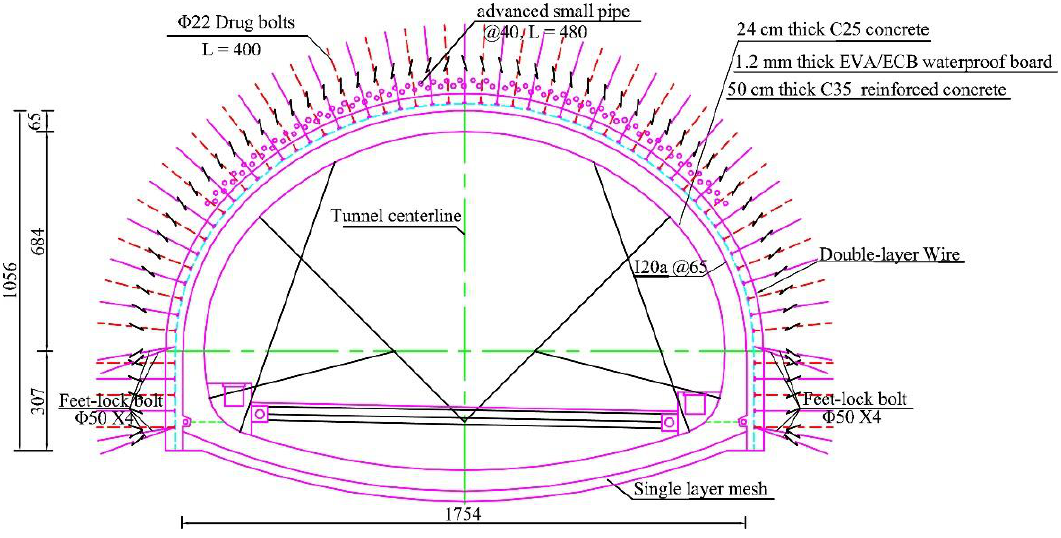
Figure 2. Tunnel section and support parameters.